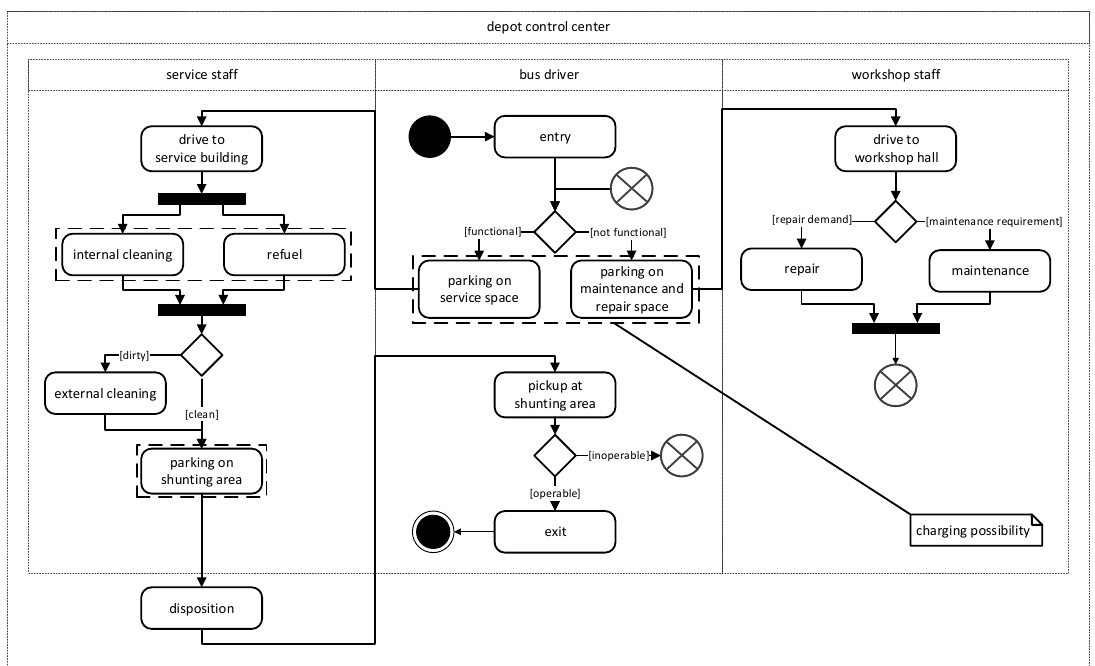
Figure 5. Operation processes coordinated by the EVS/A and highlighted charging possibilities at the depot.